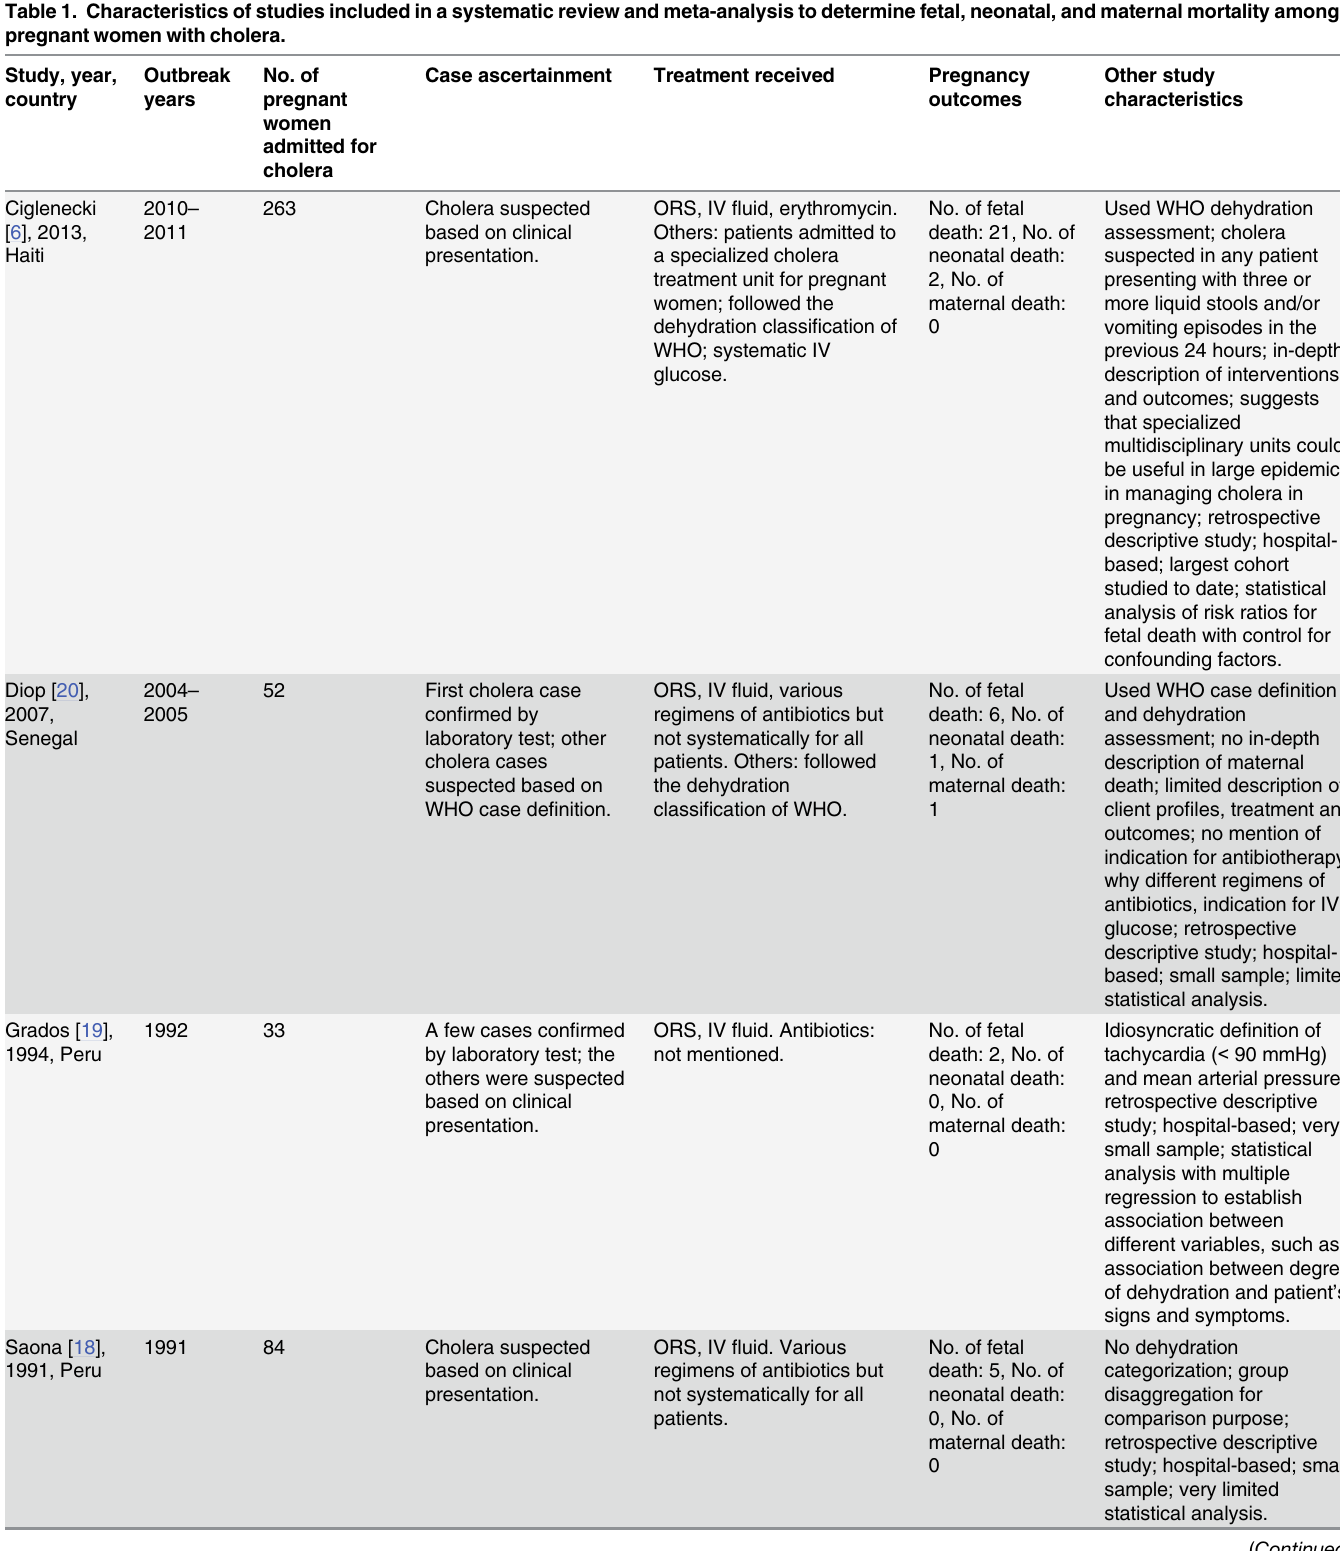
Table 1. Characteristics of studies included in a systematic review and meta-analysis to determine fetal, neonatal, and maternal mortality among pregnant women with